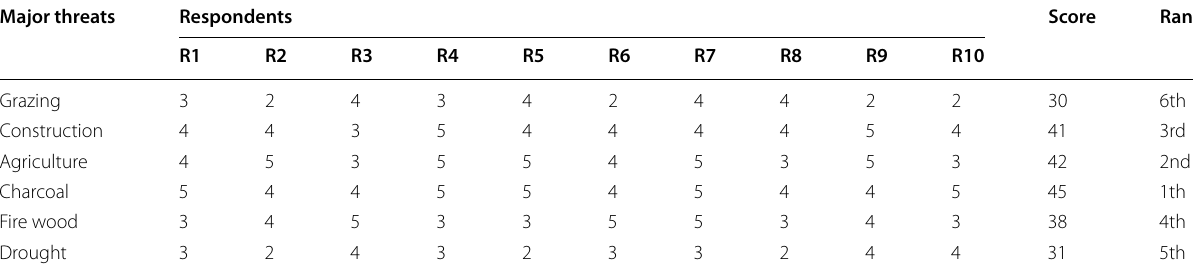
Table 9 Threats to medicinal plants in the study area Major threats Respondents